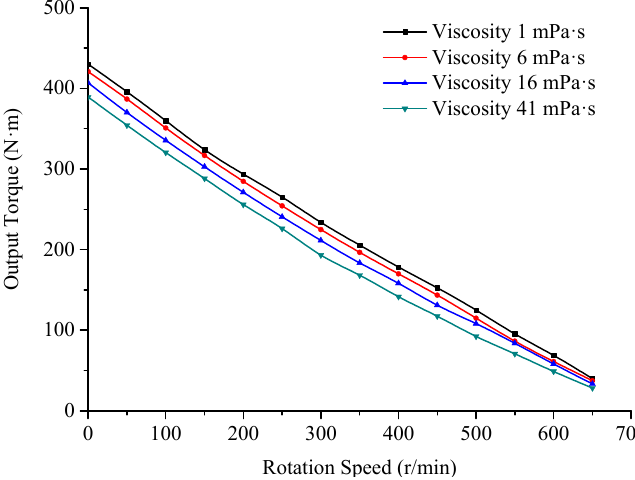
Figure 12. Torque vs. speed curves for different viscosities.